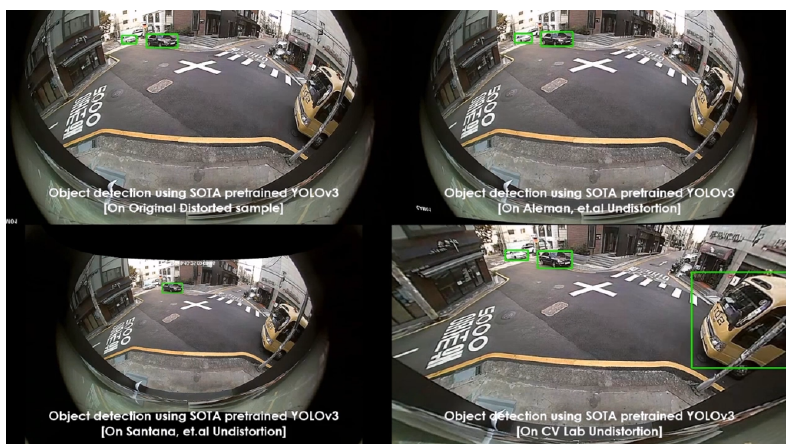
Figure 14. Pretrained YOLOv3 object detection on various rectified 190 ◦ fish-eye frames: bus detected along the edge in the proposed rectified algorithm.